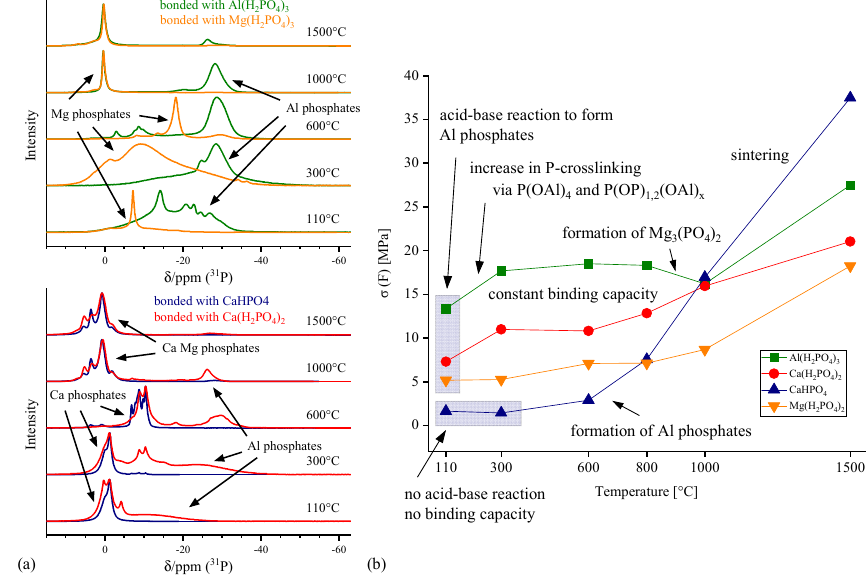
Figure 4. Correlation of the cold modulus of rupture and structural changes in the bonding phase of phosphate bonded Al 2 O 3 MgAl 2 O 4 ceramics (composition: 85 wt.% Al 2 O 3 , 15 wt.% MgAl 2 O 4 ; binder concentration: 3 wt.% P 2 O 5 ): ( a ) 31 P MAS NMR spectra of the phosphate bonded ceramics after thermal treatment (normalized) and ( b ) cold modulus of rupture tests at appropriate temperatures. The strength development of ceramic bodies can be directly correlated with the evolution of an aluminum phosphate bonding network